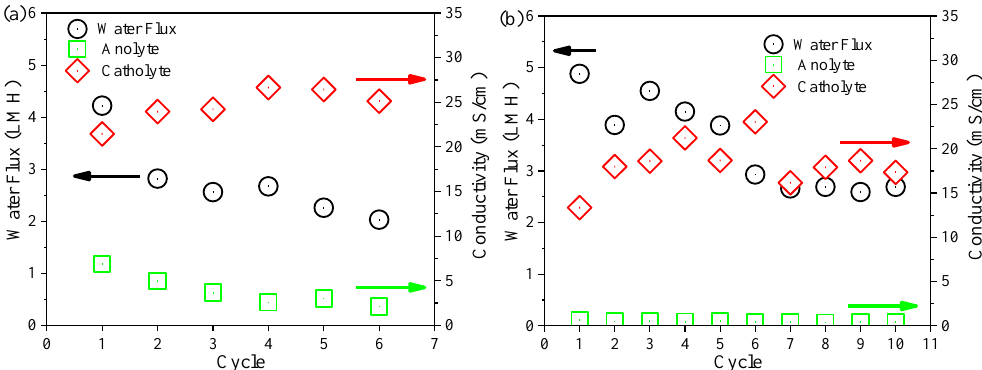
Figure 5. Variations in water flux of the FO membrane and conductivity of the anolyte and catholyte at the end of each cycle in ( a ) the control OsMFC and ( b ) AgNP-OsMFC.